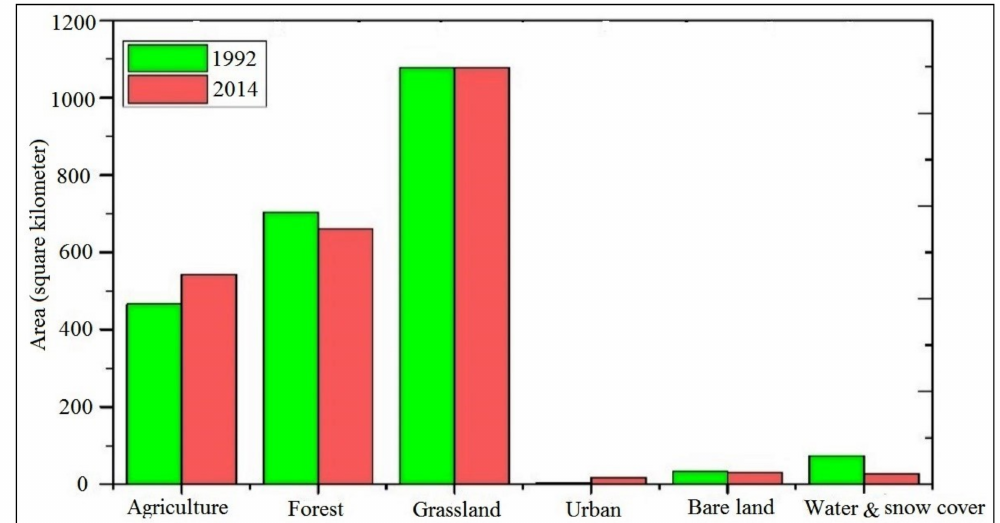
Figure 16. Land cover variations in KRB during the period